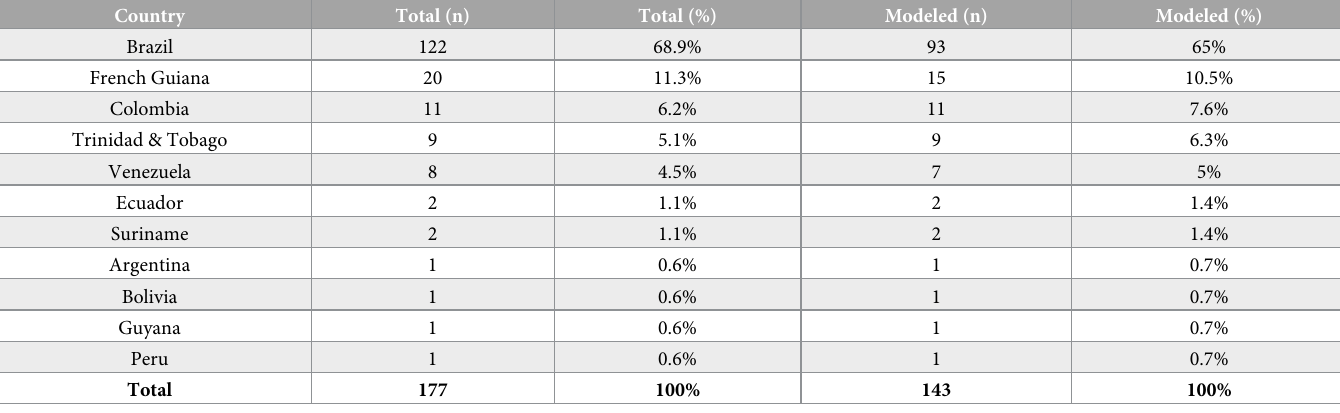
Table 1. Summary of Hg . janthinomys presence locations compiled during this study and those incorporated into the model.